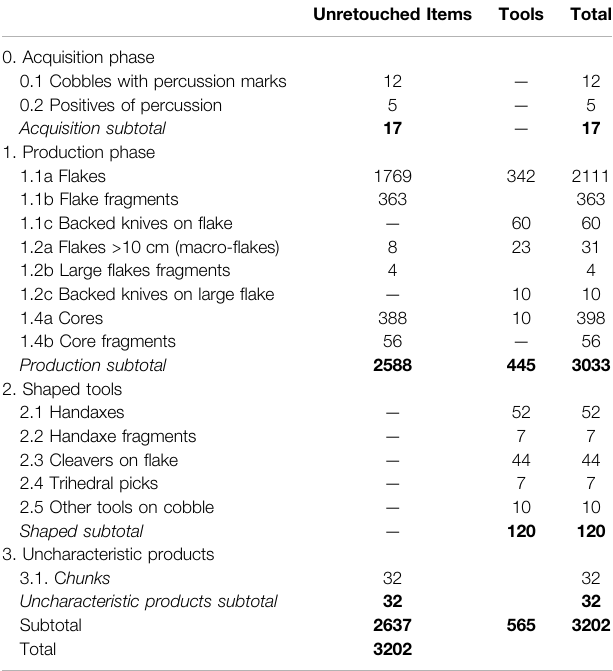
TABLE 2 | El Sotillo. Level 5 lithic industry from A and B Sectors. Totals and subtotals in bold. Unretouched Items Tools